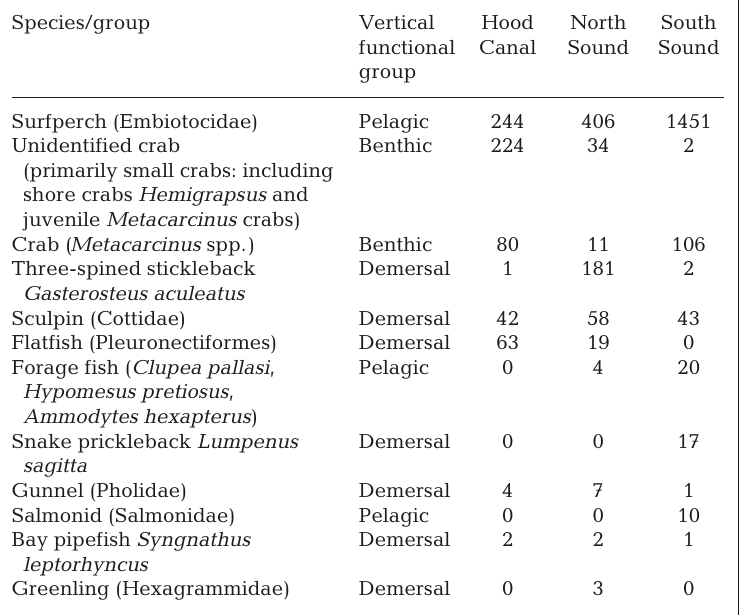
Table 3. Total observations of the 13 most common fish and crab species groups summed across farms, months, and years. Data were collected